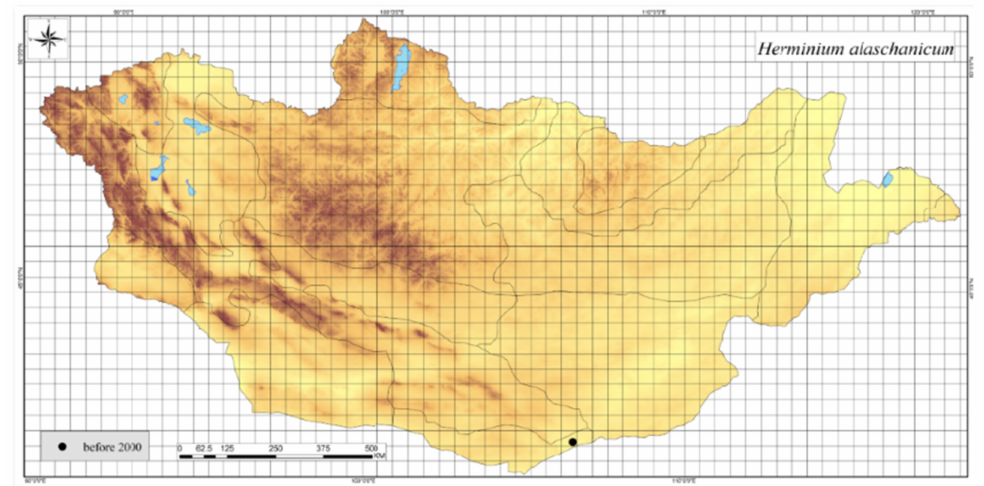
Figure A16. Distribution map of Herminium alashanicum in Mongolia.